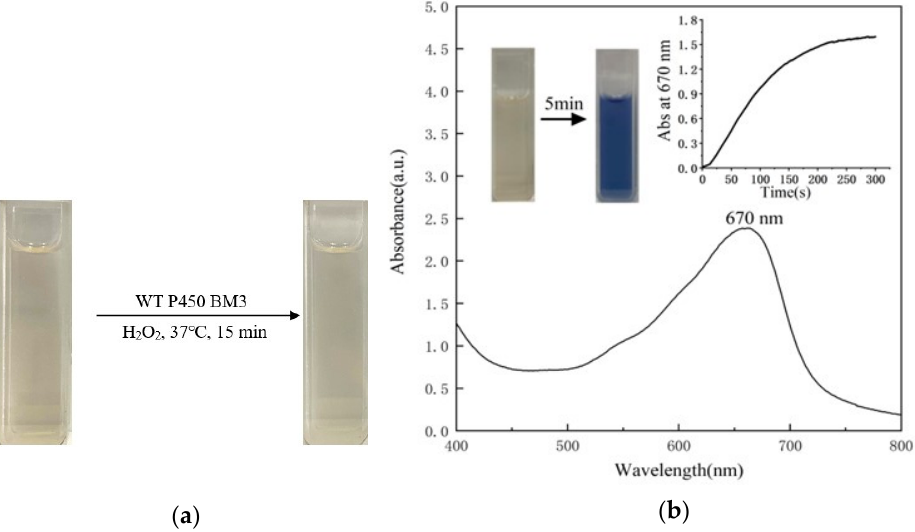
Figure 2. ( a ) The oxidation of indole (1 mM) catalyzed by WT P450 BM3 (0.5 µ M) with H 2 O 2 (30 mM) as an oxidant; ( b ) UV-vis spectral changes upon the coupling oxidation of indole catalyzed by F87A P450BM3 mutant. Time-dependent changes of the absorbance at 670 nm and the color change of the solution are shown as insets.